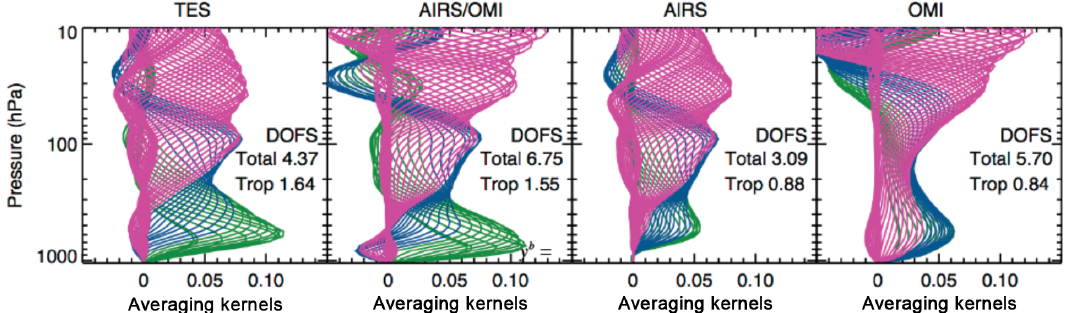
Figure 1. Averaging kernels of collocated measurements of TES (version 6), joint AIRS + OMI, AIRS alone, and OMI alone over California, USA, on 23 August 2006. The green, blue, and magenta curves in four panels indicate the averaging kernels in the pressure range of surface– 400hPa, 400–100hPa, and above 100hPa, respectively.